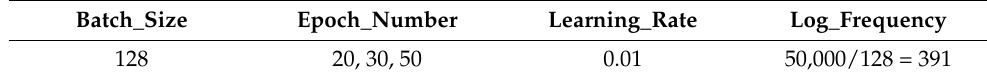
Table 2. The basic network parameter settings.